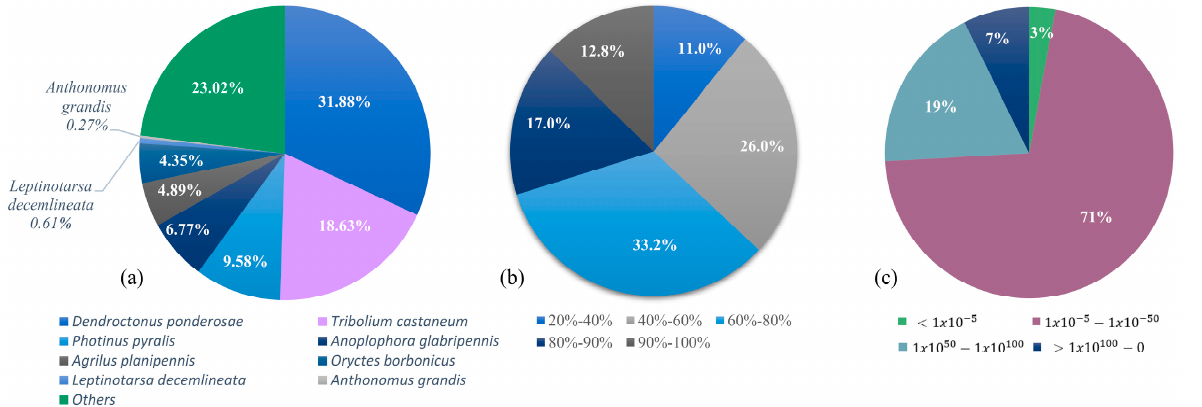
Figure 2. Species annotation obtained from A. eugenii head transcriptome mapped against the Insecta-UniProtKB database with BLASTx. ( a ) Species distribution; ( b ) identity percentage distribution; ( c ) e-value distribution.